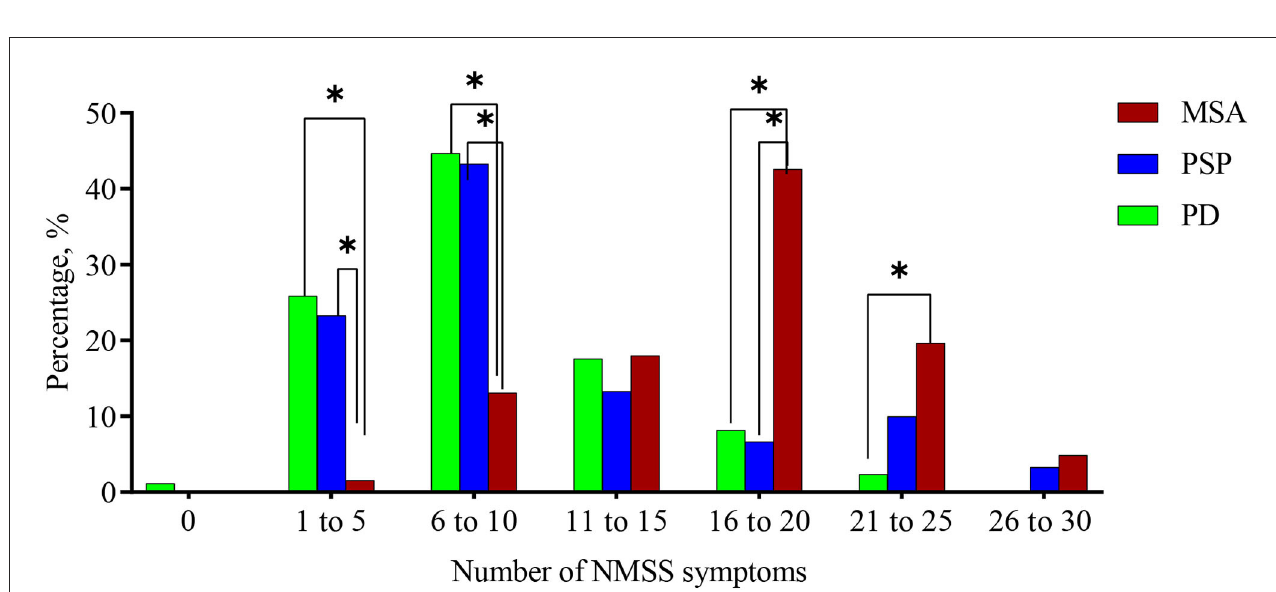
FIGURE3 Distribution of the number of non-motor symptoms in MSA, PD, and PSP. The proportion of patients with 16–20 non-motor symptoms was higher in the MSA group than in PD and PSP groups (all p < 0.05); There was a higher proportion of patients with 21–25 non-motor symptoms in MSA than in PD ( p < 0.05). The proportion of patients with 1–5 or 6–10 non-motor symptoms was higher in the PD and PSP groups compared to the MSA group (all p < 0.05). * Represents p -value ≤ 0.05 between two disease entities. MSA, multiple system atrophy; PD, Parkinson’s disease; PSP, progressive supranuclear